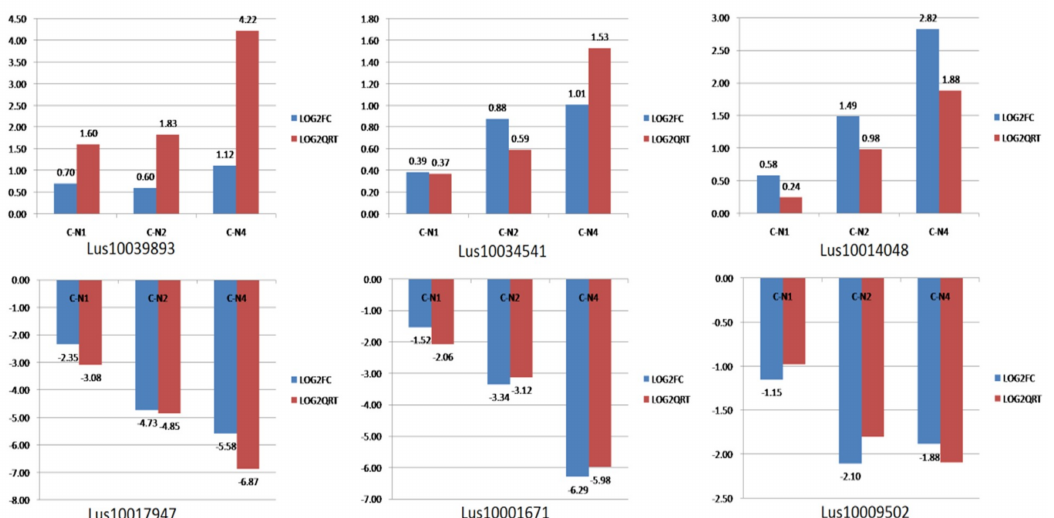
Figure 7. Validation of the RNA-seq data expression profile by qRT-PCR. The relative expression levels of 6 DEUs were calculated according to the 2 − ∆∆ Ct method using the Actin gene as an internal reference gene. The x -axis indicates the different exposure of 100 mM NaCl solution with 12 h (C-N1), 24 h (C-N2) and 48 h (C-N4). LOG2FC and LOG2QRT represent for the binary logarithm of fold changes of differentially expressed genes in RNA-seq and qRT-PCR, respectively.